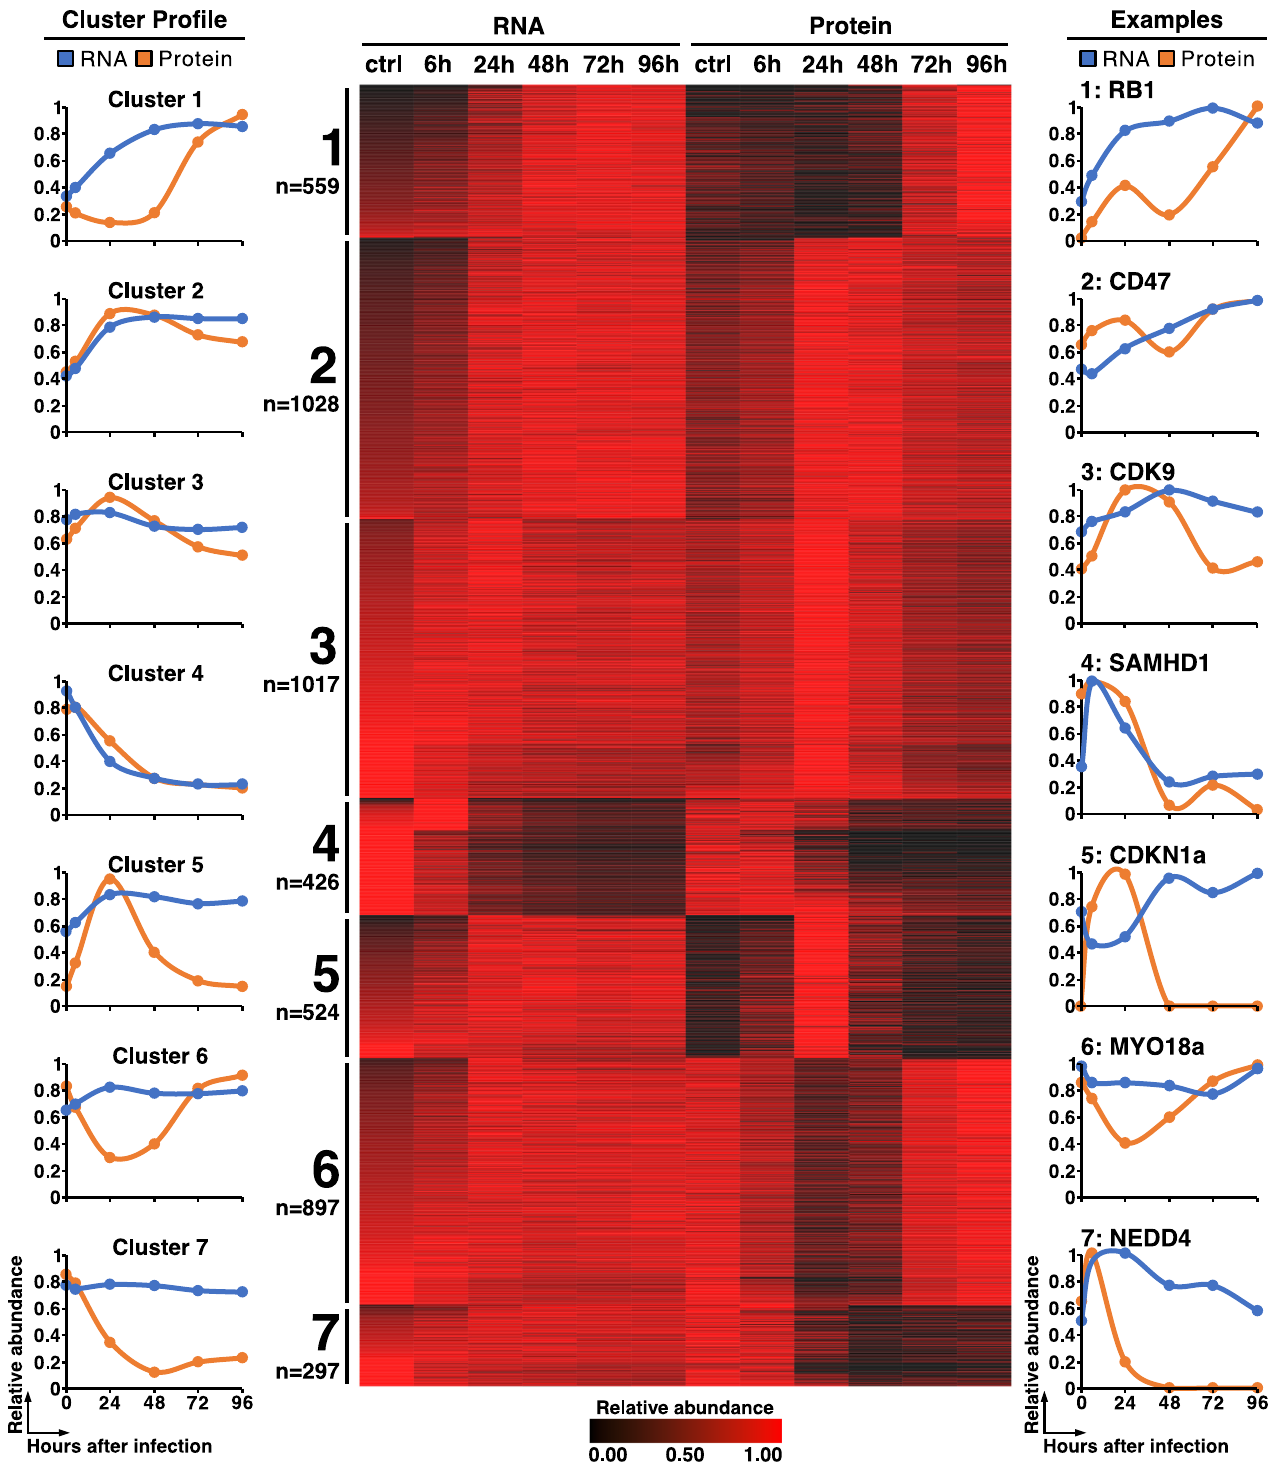
Fig 8. Comparative analysis of CCMV-induced changes in host gene expression at the transcript and protein level. At the indicated time points total RNA and protein were prepared from CCMV- infected cells and analyzed by RNA sequencing and tandem mass spectrometry respectively. K-means clustering of 4,748 transcripts and proteins identifies seven individual clusters representing different modes of host gene regulation during CCMV infection. Shown are the average mRNA and protein profiles of each cluster (left panel), a heatmap of the corresponding gene expression data (middle panel) and selected representative profiles from each cluster (right